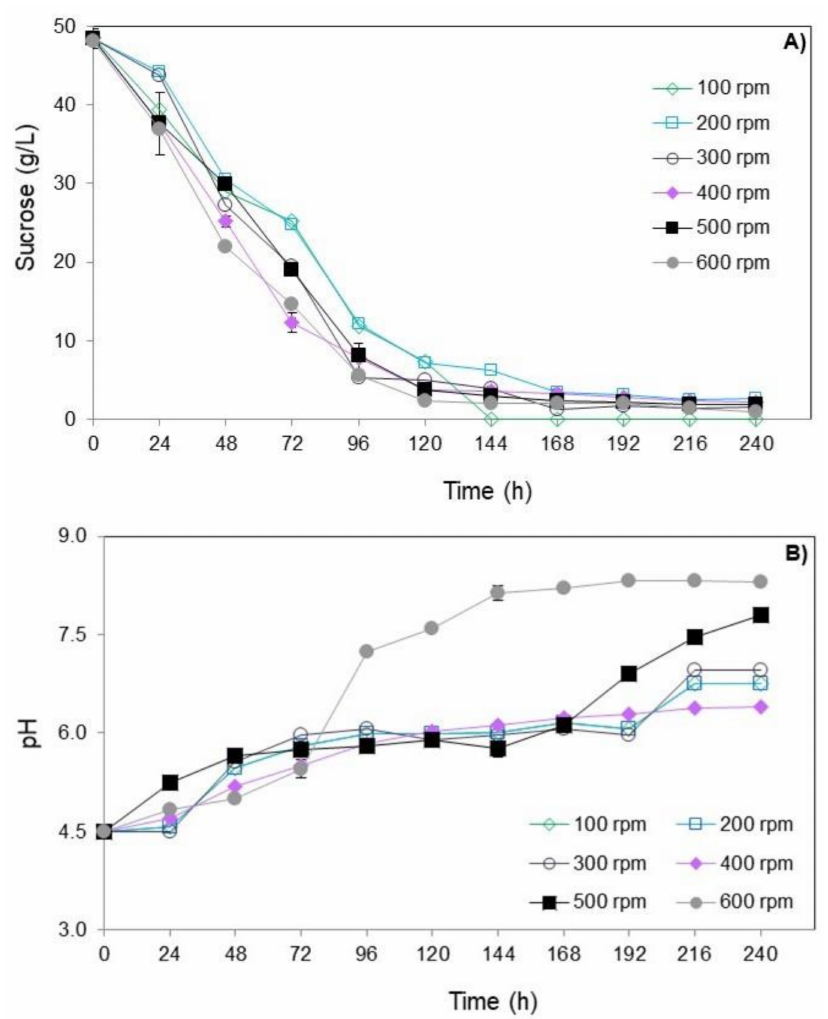
Figure 2. Consumption of sucrose ( A ) and pH ( B ) over time (0 to 240 h) of submerged culture of T. amestolkiae in stirred-tank bioreactor varying the stirring speed (100 to 600 rpm) at 2.0 vvm and 30 ◦ C. The error bars represent 95% confidence levels for the